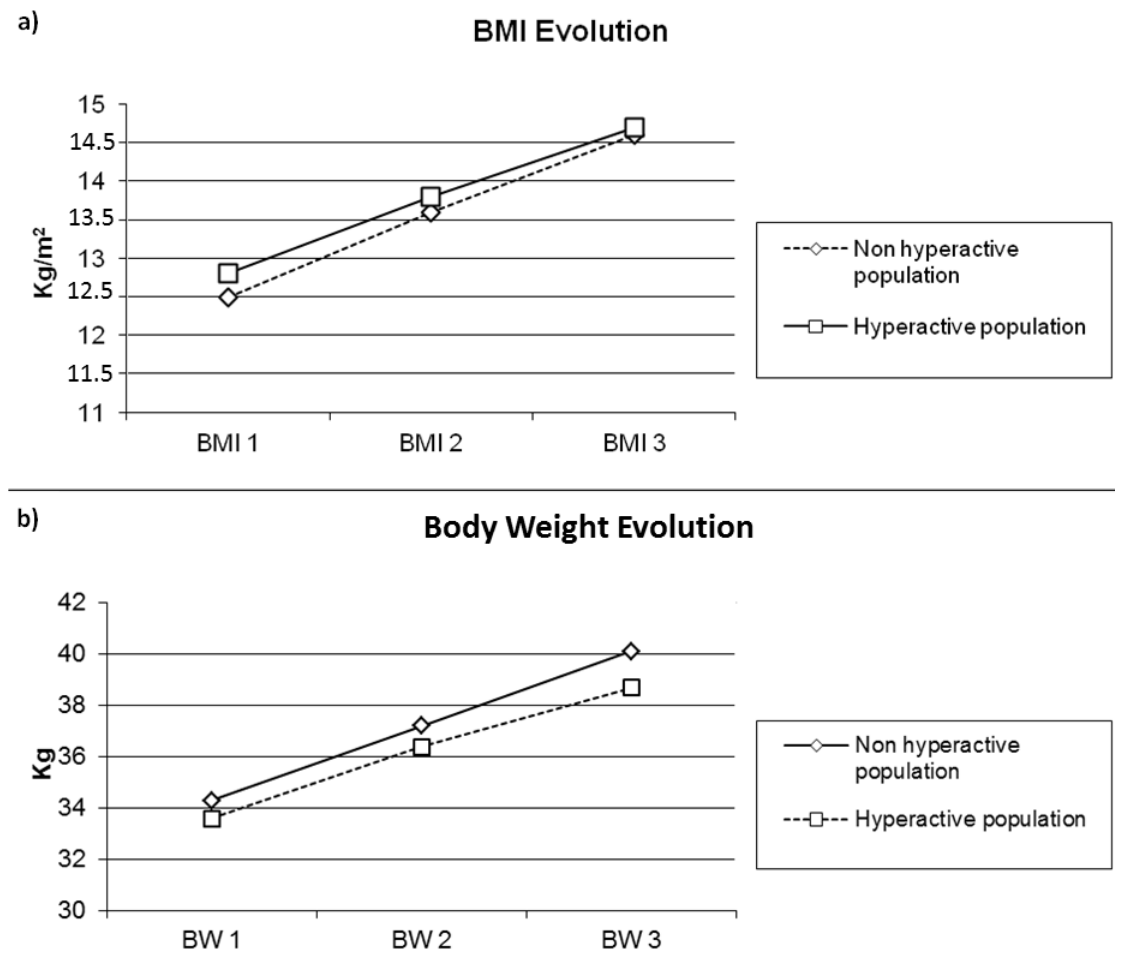
Figure 1. ( a ) Body Mass Index evolution and ( b ) Body Weight evolution according to hyperactivity or not in patients with anorexia nervosa. Abbreviations: BW: Body weight; BMI: Body Mass